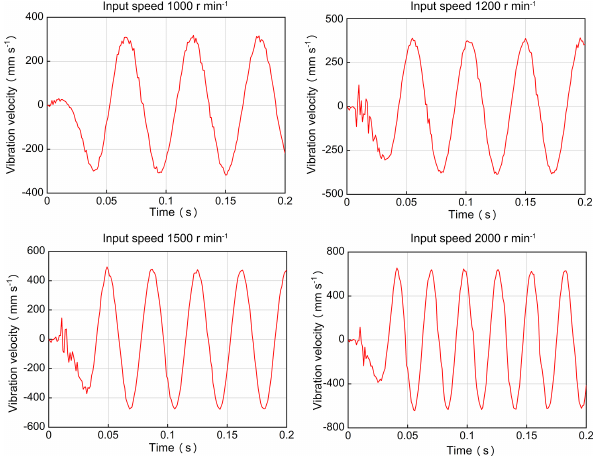
Figure 15. Dynamic contact force in 1050rmin − 1 on different axes.